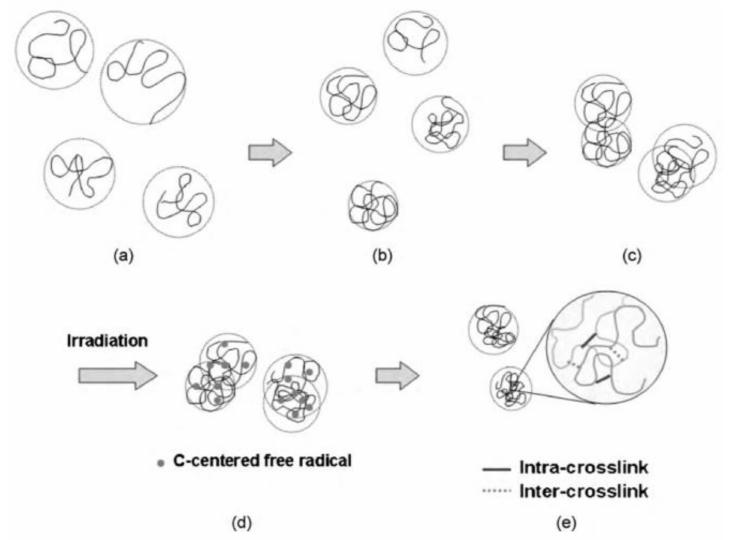
Figure 4. Synthesis of: ( a ) PVP NGs, dilute solution (c = 0.9 × 10 − 3 mol L − 1 ); ( b ) High temperature, collapsed coils; ( c ) Diffusive interaction of coils; ( d ) C-centered radical formation; ( e ) Intra- and inter-crosslinks of PVP. Adapted with permission from [24]; published by Elsevier, 2010. Disproportionation reactions often compete with recombination reactions because both occur in similar yields, while for some polymers, like poly(vinyl alcohol), it has